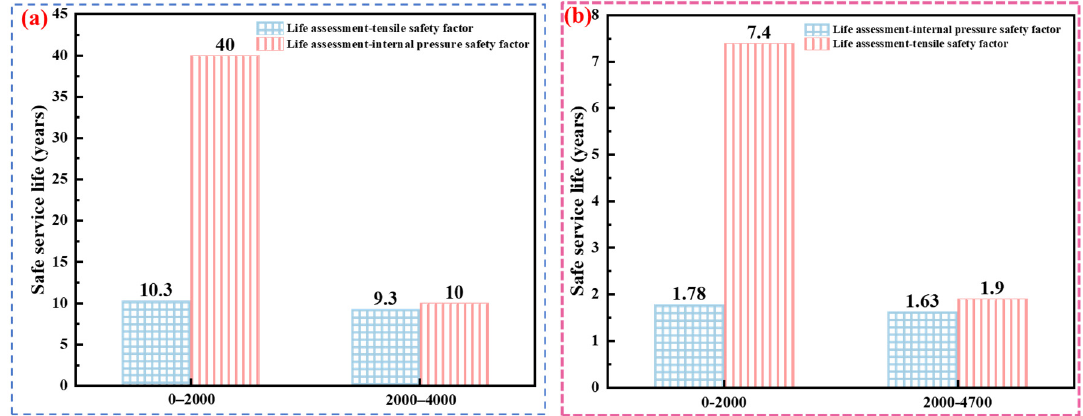
Figure 18. The safe service life of T95 steel in the gas ( a ) and liquid ( b ) phases.